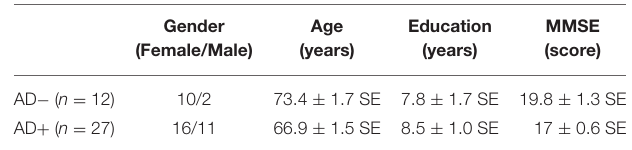
TABLE 8 | Demographic and clinical data of the subgroups of AD patients (AD − and AD + ) in the subpopulation of 39 AD patients having MRI data associated to EEG